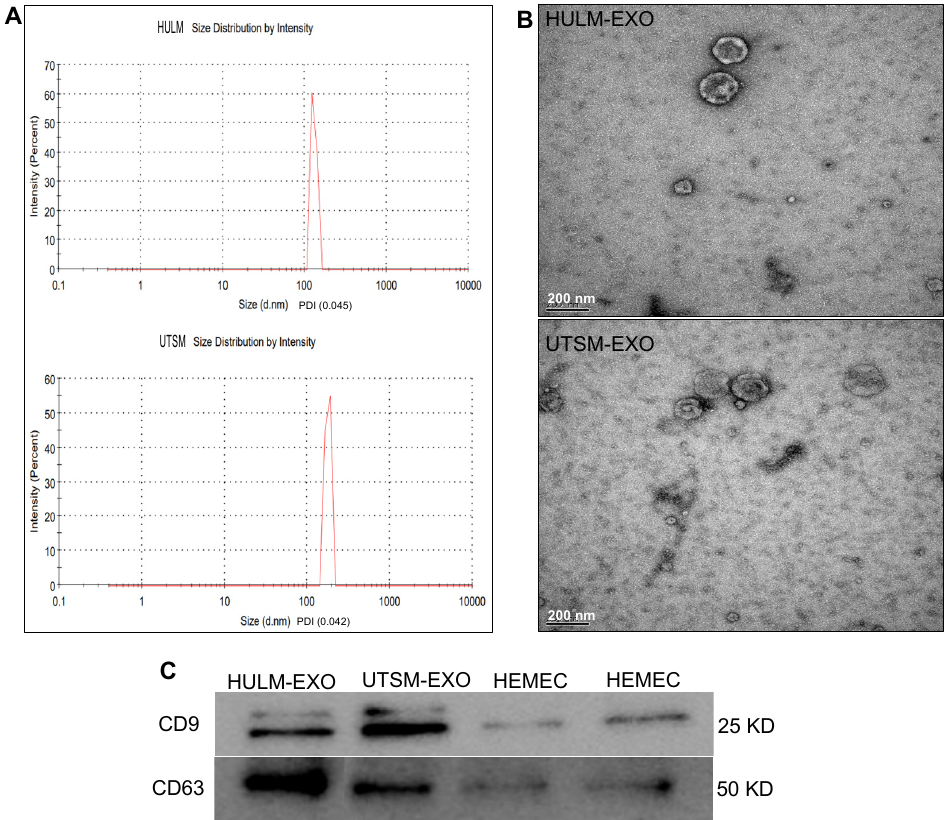
Figure 1. Isolation and depiction of exosomes derived from human uterine leiomyoma cell line. ( A ) nanoparticle tracking analysis (NTA) confirmed the dimension of exosomes ranging in size from 30 to 160 nm, and PDI of 0.045 and 0.042, displaying the graphs of HULM- and UTSM-derived exosomes in X -axis: diameter (nm) and in Y -axis: peak intensity. ( B ) representative micrographs of transmission electron microscopy (TEM) showed the cup-shaped expected morphology of HULM- and UTSM-derived exosomes (scale bar = 200 nm). ( C ) Western blotting demonstrated the expression of exosomal markers, CD9 and CD63, and confirmed the purity of the isolated exosomes. These images are representative of independent experiments. HULM: human uterine leiomyoma cells, UTSM: human uterine smooth muscle cells, HEMEC: human endometrial microvascular endothelial cells, and EXO: exosomes.